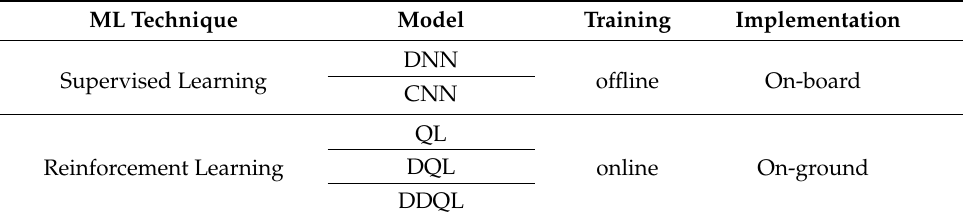
Table 3. Features of the ML models evaluated.